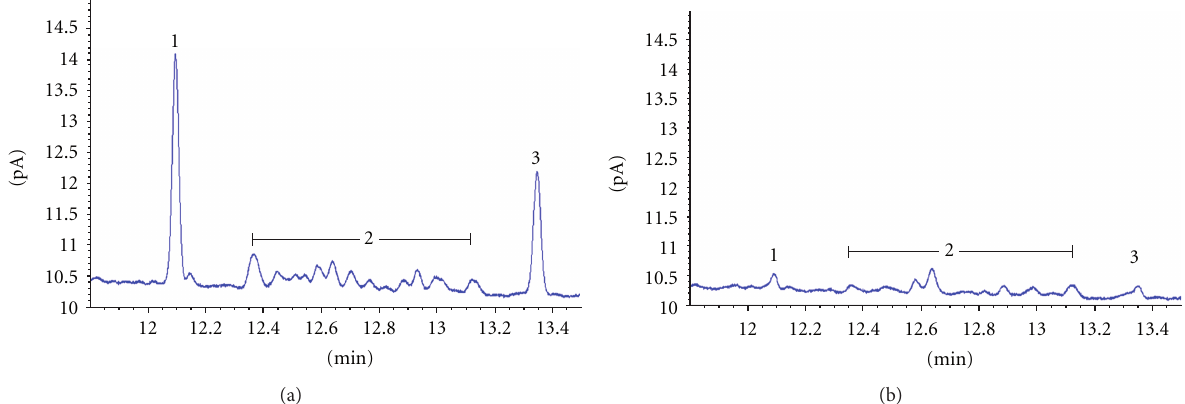
F 8: Extracted chromatograms wastewater (a) aer 3 hours exposure of UV radiation without catalyst and (b) aer addition of TiO graphene composite (1:0.1 ratio) with UV exposure for 3 hours. Peak identi�cation: (1) 4-n-heptylphenol, (2) 4-nonylphenol (mixture of isomers), (3)